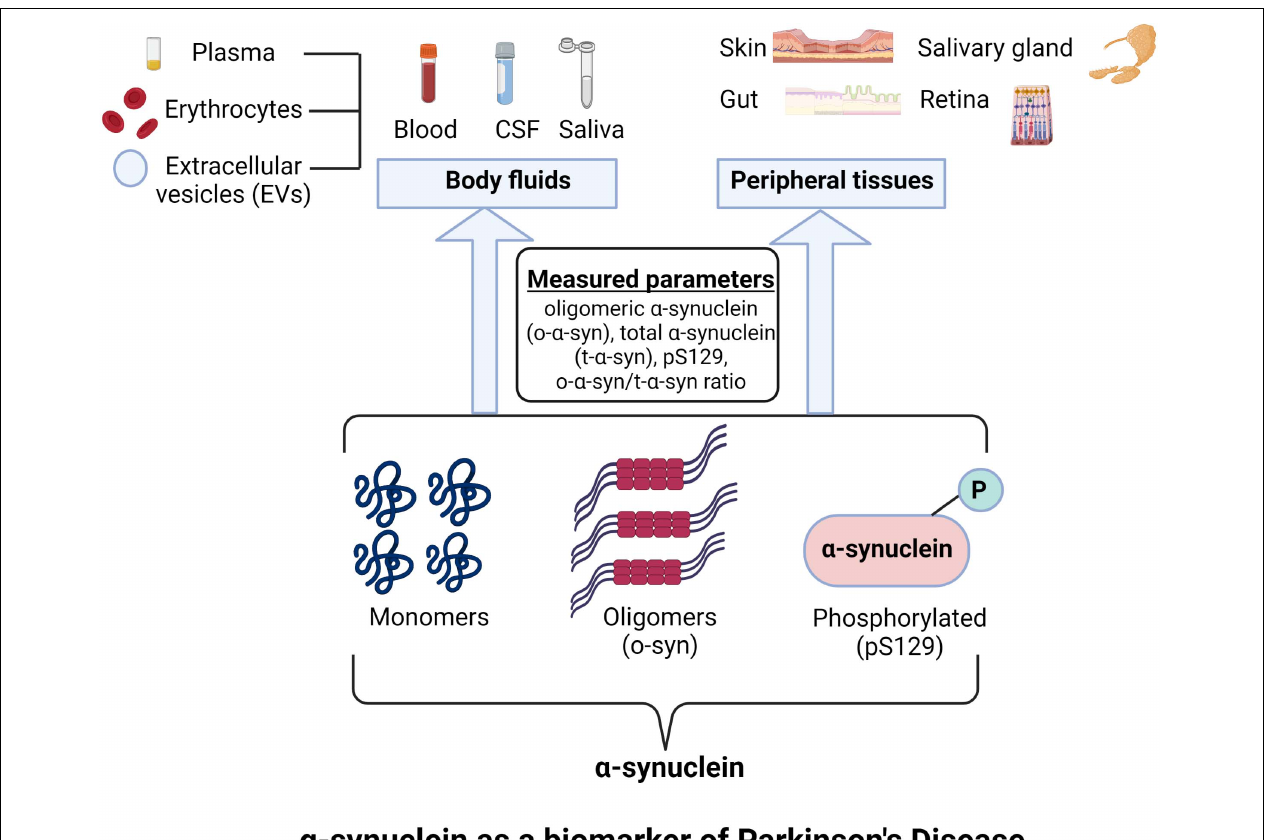
FIGURE 1 | Different forms of α -Synuclein as a prospective biomarkers in Parkinson’s disease (PD). Image was created using